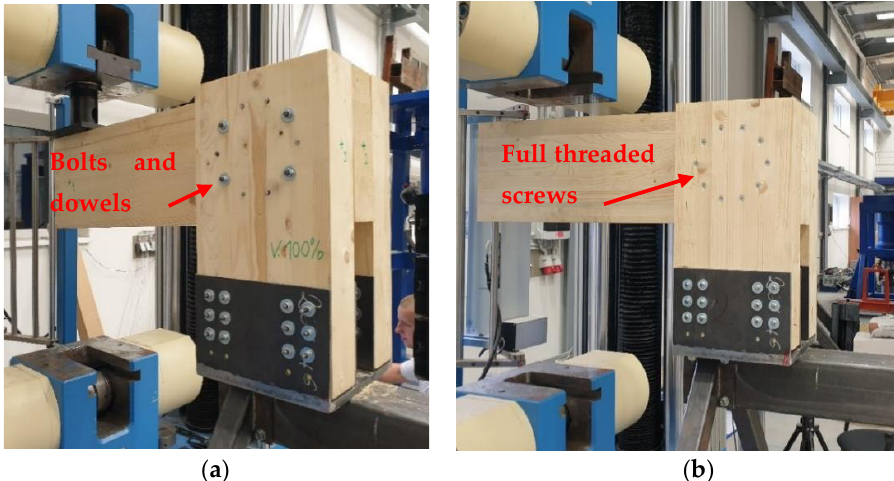
Figure 5. Experimental specimens: ( a ) Experiment A, bolts and dowels; ( b ) Experiment B, fully threaded screws; see Johanides 2022 [43].